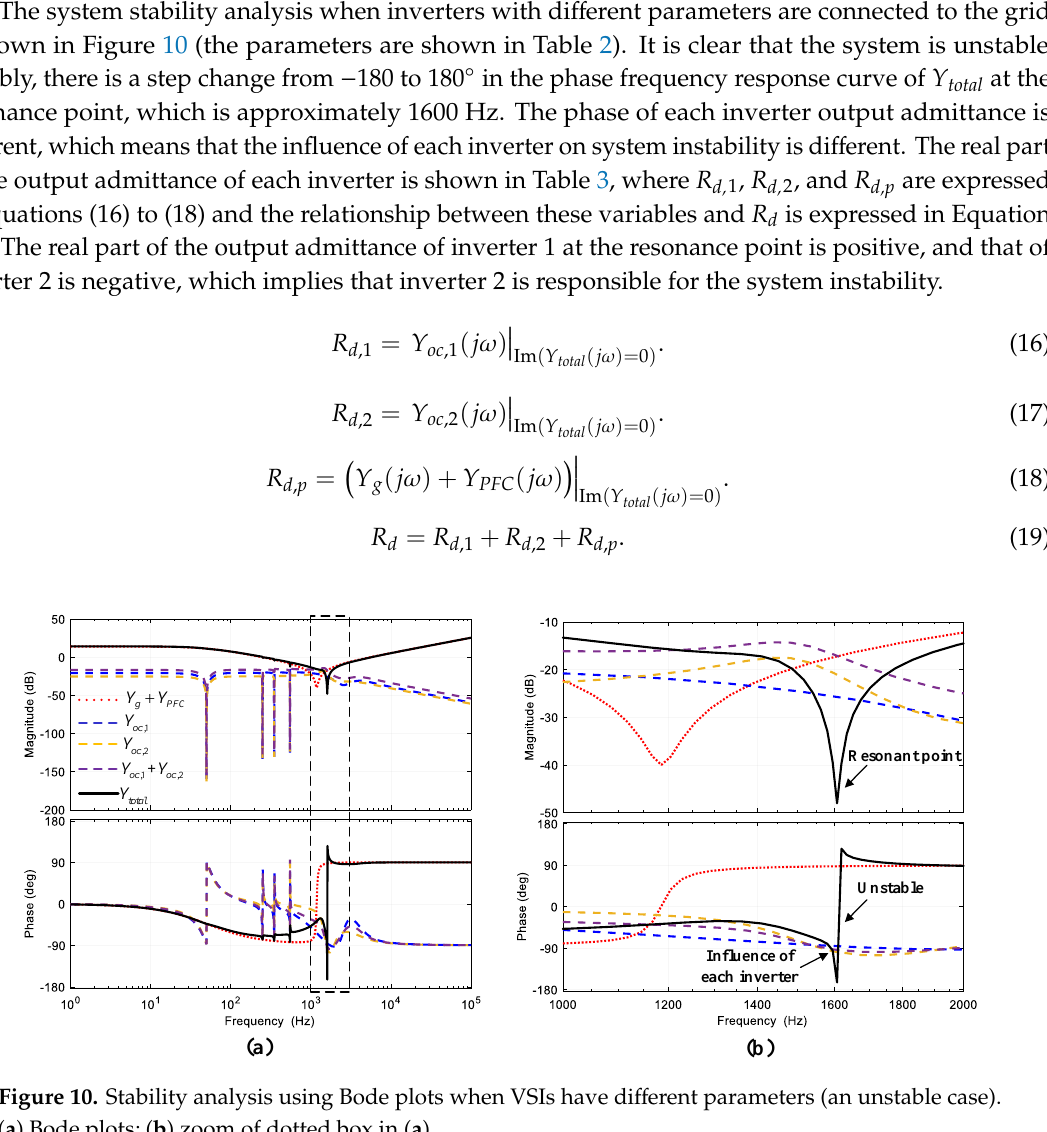
Figure 10. Stability analysis using Bode plots when VSIs have different parameters (an unstable case). ( a ) Bode plots; ( b ) zoom of dotted box in ( a ).